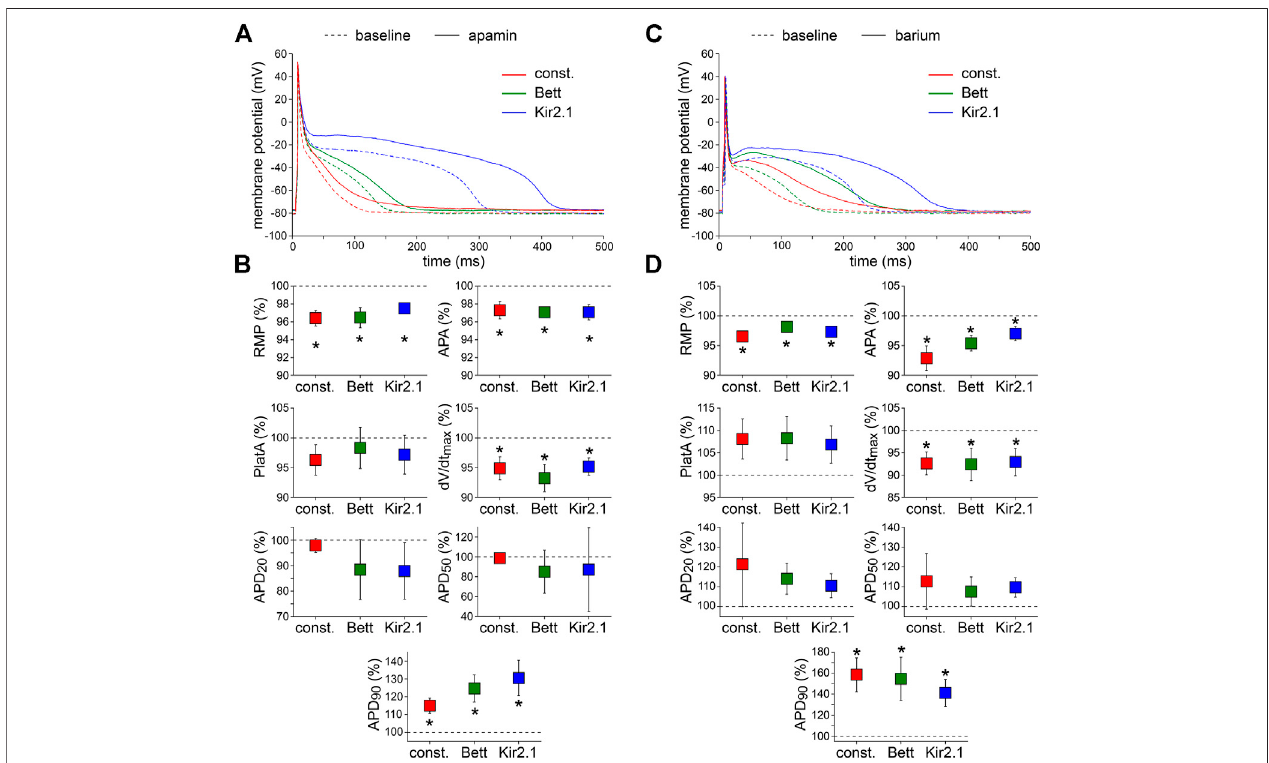
FIGURE5| Effects ofapamin and barium on APsmeasured withconstantand I K1 current injection. (A) TypicalAPs ofoneatrial myocyte inabsence(baseline) and presenceofapamintoblocktheCa 2+ -dependentK + current. (B) AverageAPparametersmeasured in fi vecellsinpresenceofapamin. APparameters arenormalizedto the APparametersmeasured under baseline conditions inthesame cell. (C) TypicalAPsofoneatrialmyocyteinabsence(baseline) and presenceofbarium toblockthe nativeI K1 . (D) Average APparameters measuredinfour cellsin presence ofbarium.APparametersarenormalized totheAPparameters measuredunder baseline conditions in the same cell. * p < 0.05, drug vs. baseline (paired t